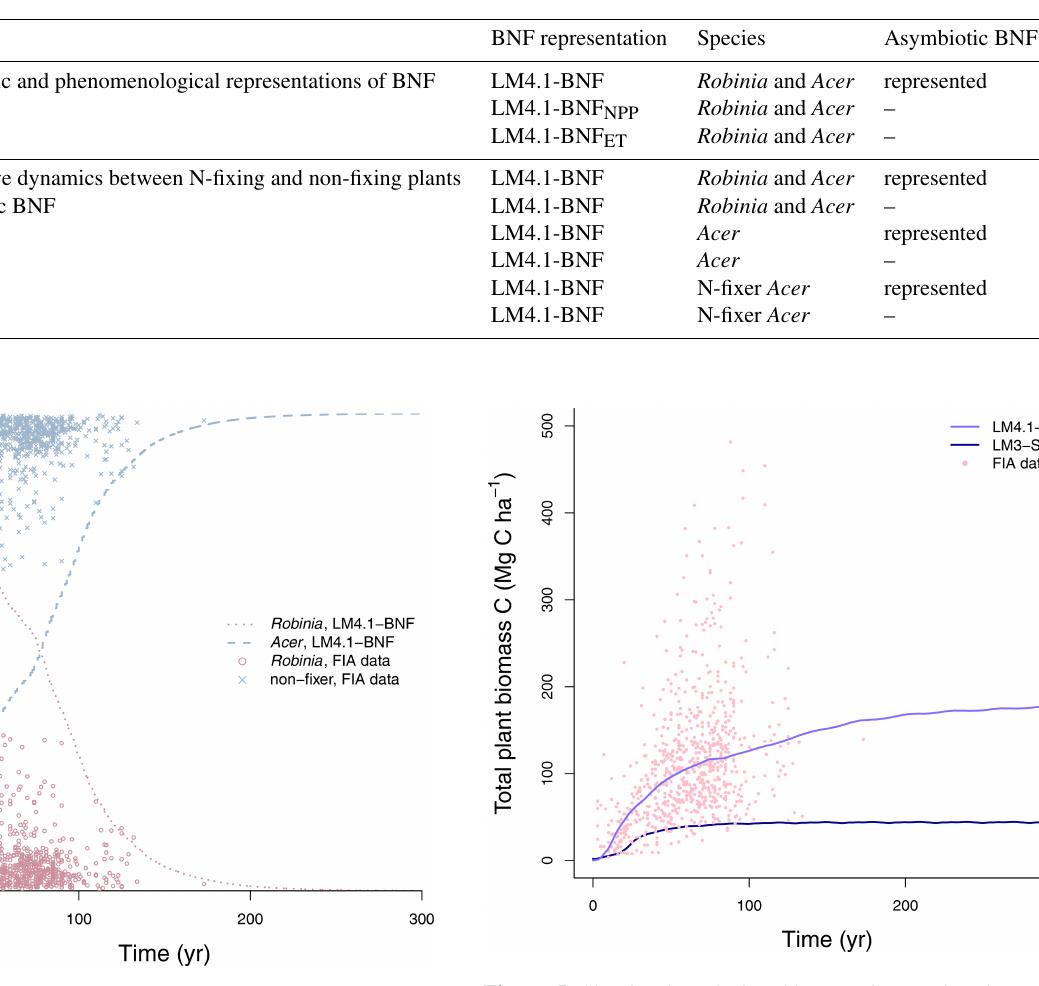
Figure 4. Simulated relative basal area of Acer and Robinia over time compared to FIA data (in North Carolina). Simulated data are trees with dbh > 12 . 7cm to reflect the dbh range of FIA data. FIA data of all non-fixing trees are aggregated to represent Acer . Each point represents an FIA plot. See Fig. D9 for absolute basal area.